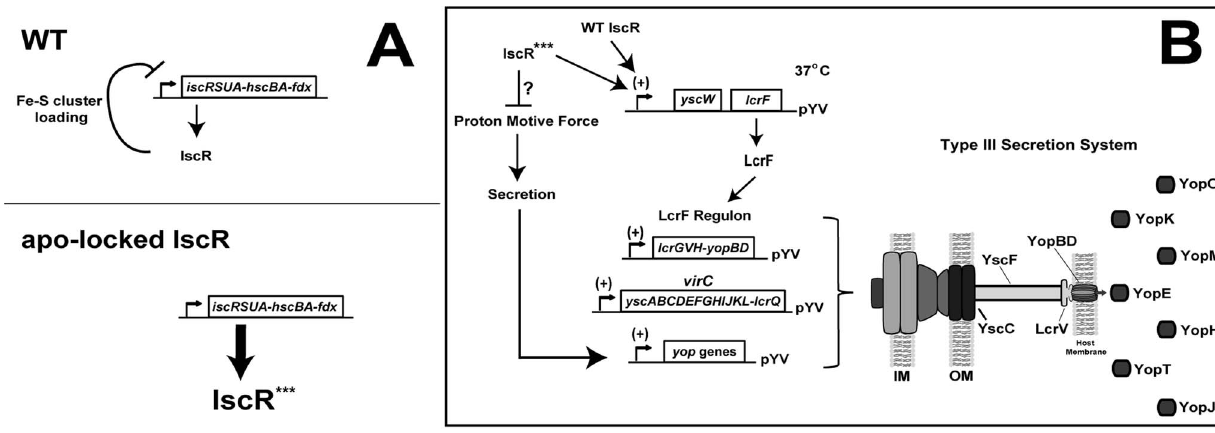
Figure 9. Regulation of the isc and lcrF operons by IscR. ( A ) Model of isc operon transcriptional control in the Y. pseudotuberculosis wild type and apo-locked IscR strains based on previous work on E. coli IscR [32,34] and on data shown here. In wild type bacteria, the Isc Fe-S cluster biogenesis pathway loads a [2Fe-2S] cluster onto IscR (holo-IscR) [32], which recognizes a type 1 DNA-binding motif in the isc promoter to repress transcription in a negative feedback loop. Expression of the apo-locked IscR allele (***, IscR-C92A/C98A/C104A) results in loss of holo-IscR-mediated repression, thereby increasing transcription of the isc operon relative to wild type, resulting in a 30-fold increase in iscR . ( B ) Model depicting the mechanism by which IscR controls the Y. pseudotuberculosis Ysc T3SS. Holo- and apo-IscR are predicted to bind a newly identified type 2 DNA-binding site within the yscW-lcrF operon encoding the LcrF T3SS master regulator. Subsequently, LcrF expression leads to transcription of the LcrF regulon, which includes the lcrGVH-yopBD and virC operons and yop genes [17,20,22,53,54]. These genes encode the majority of T3SS structural, regulatory, and effector proteins. However, through an as yet undefined mechanism, overexpression of apo-locked IscR leads to a decrease in the proton motive force, which is required for type III secretion [50]. As Yop secretion positively regulates yop gene transcription [51,52], the secretion defect of the apo- locked IscR mutant is predicted to lead to a decrease in effector yop transcription.